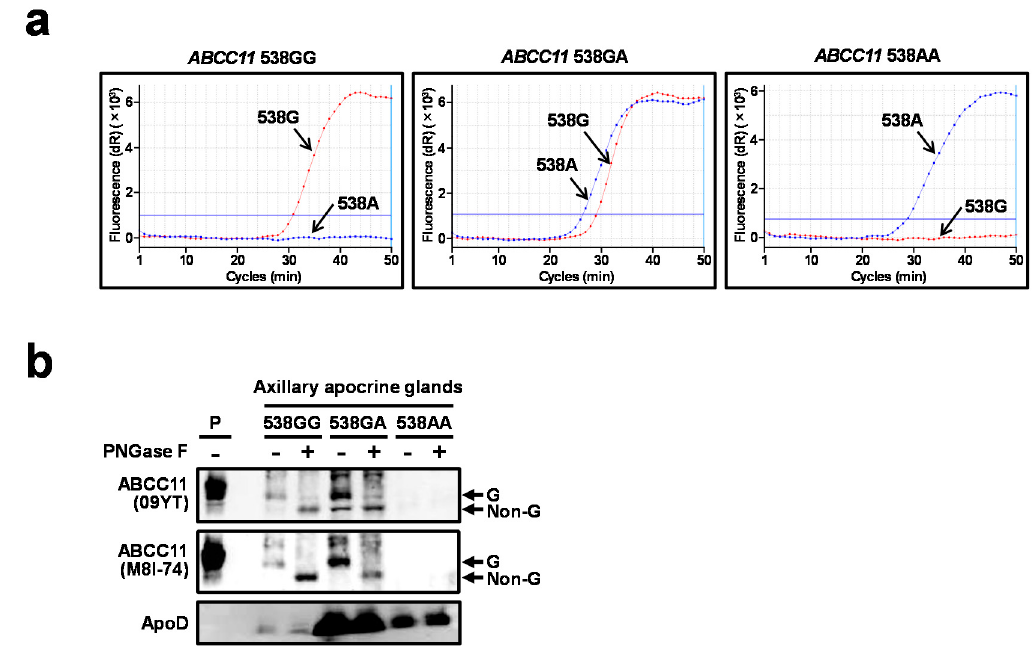
Figure 2. Expression of ABCC11 protein in the extracted subcutaneous tissues containing axillary apocrine glands in axillary osmidrosis (AO) patients carrying ABCC11 538G. ( a ) Time-dependent signal increase for the genotyping at ABCC11 538G>A by the SmartAmp method. Changes in fluorescence intensity of SYBR Green I dye with allele-specific primers (red: 538G; blue: 538A) were monitored under isothermal conditions (60 °C, 1 min/cycle) by using an Mx3000P QPCR system (Agilent Technologies, Santa Clara, CA, USA); ( b ) Immunoblotting analysis of the axillary apocrine glands extracted from the AO patients. The same amount of protein was loaded in each SDS-PAGE lane. Successful detection of ABCC11 and ApoD in the 538GG and GA lanes should ensure that enough amount of whole tissue lysate sample for the qualitative evaluation of ABCC11 protein level was loaded in the 538AA lanes where the middle levels of ApoD in a set of measurements were determined. ABCC11 protein expression was determined by using anti-ABCC11 antibodies 09YT and M8I-74. ApoD: apolipoprotein D, an apocrine gland marker. P: positive control; whole cell lysate of ABCC11 WT-expressing 293A cells. G: glycosylated, Non-G: non-glycosylated form of the ABCC11 protein.